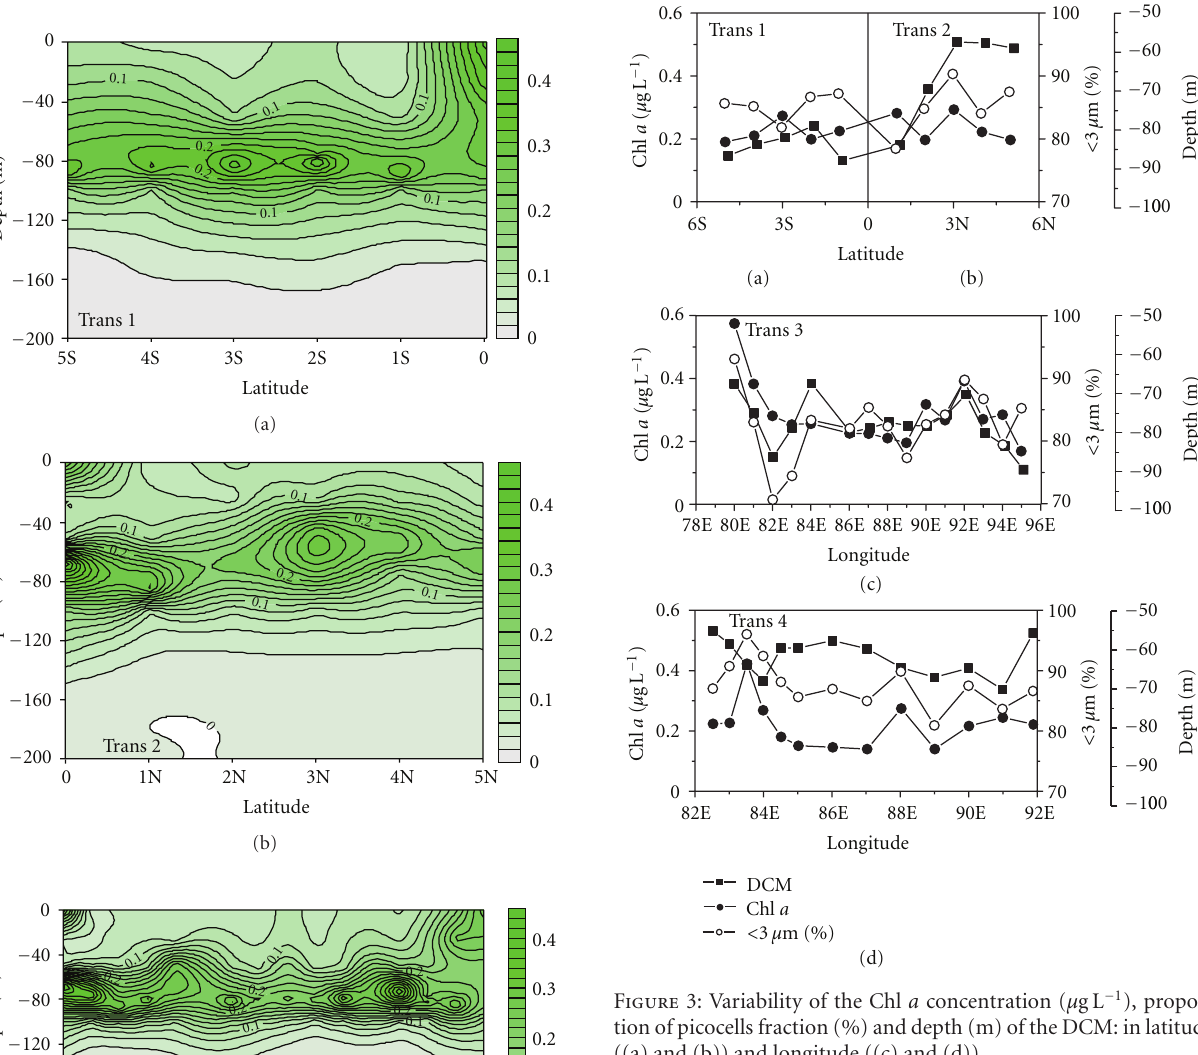
(Figure 2). The most conspicuous feature relating to the pattern of vertical Chl a distribution was the location of the DCM, which varied greatly and shoaled latitudinally to northward (Figures 2(a) and